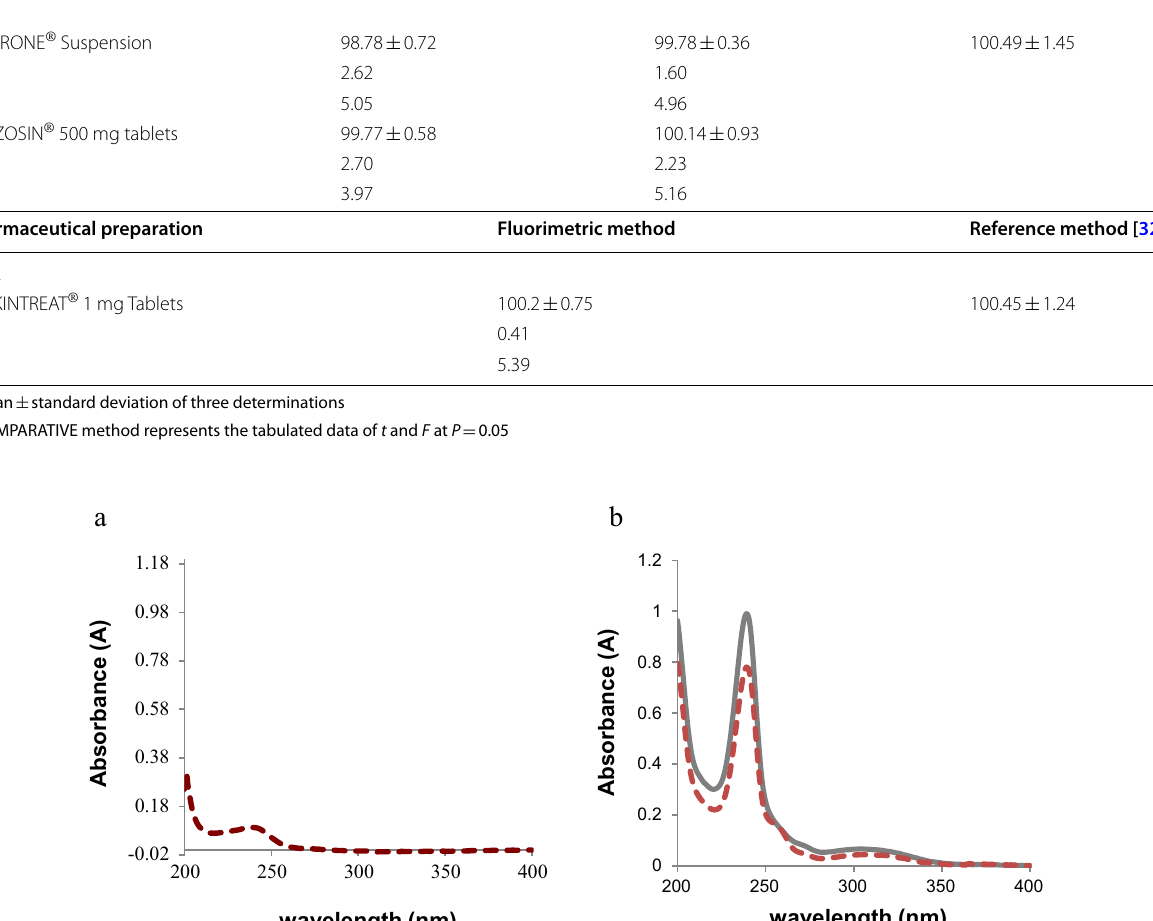
Table 2 Application of the proposed methods for determination of AZN and RSGL for five determinations